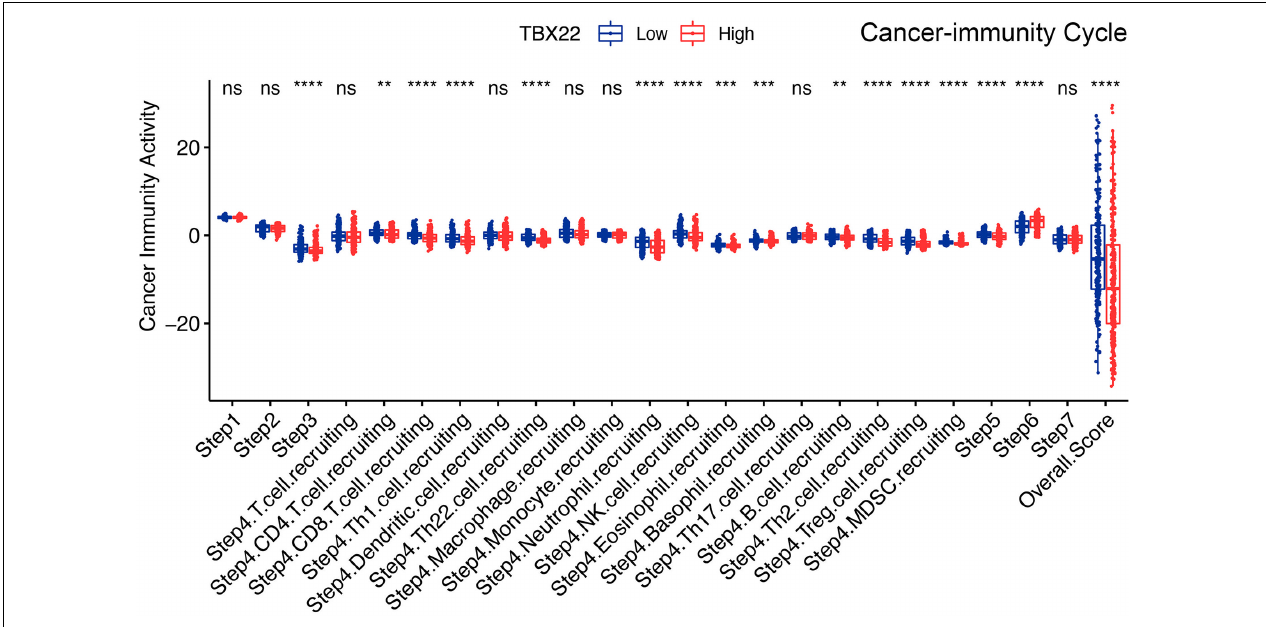
FIGURE 8 | Comparison of the activity of the cancer immunity cycle between the TBX22 high and TBX22 low groups. ** p < 0.01, *** p < 0.001, **** p < 0.0001. The scattered dots represent all score values, and the thick line represents the median value within each group. The bottom and top of the boxes are the 25th and 75th percentiles (interquartile range). The difference between TBX22 high and TBX22 low groups was compared through the two-sided Wilcoxon rank-sum